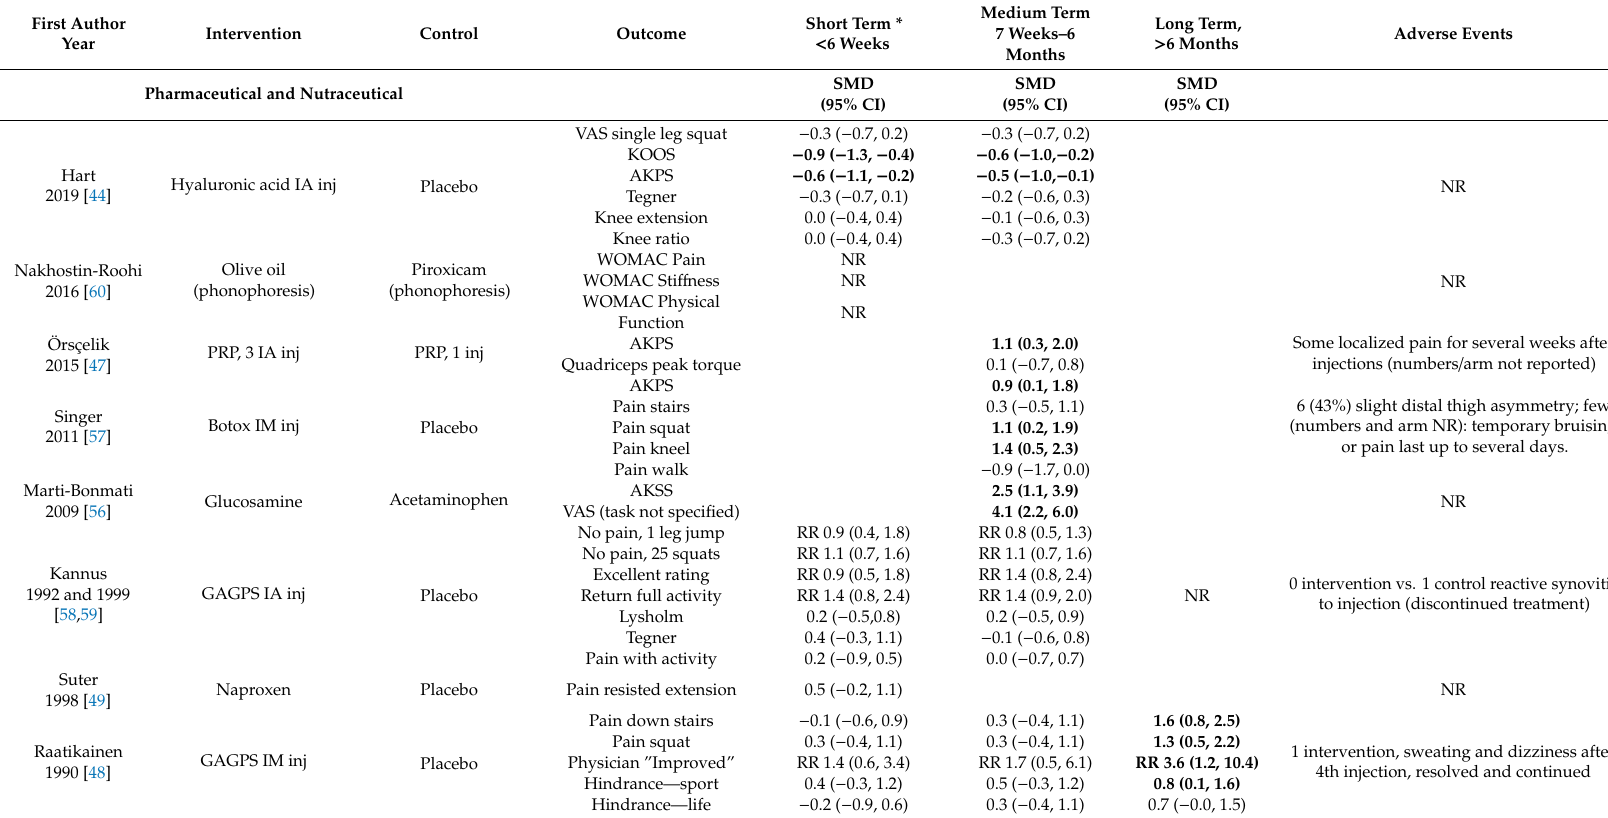
Table 3. Standardized mean di ff erences (SMD) and relative risks (RR) of all included studies (SMD > 0 and RR > 1 indicate improvement of intervention group relative to